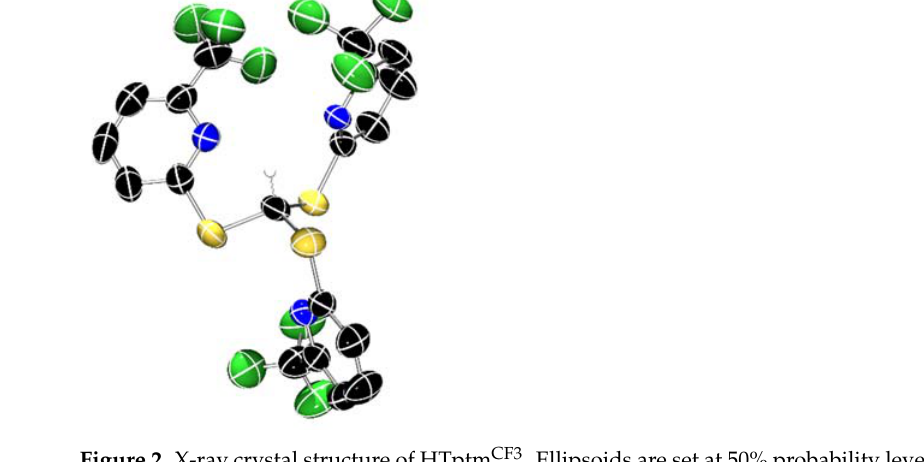
Figure 2. X-ray crystal structure of HTptm CF3 . Ellipsoids are set at 50% probability level, and selected hydrogen atoms and disordered fluorine atoms have been excluded for clarity. C: black; N: blue; S: yellow; F: green.